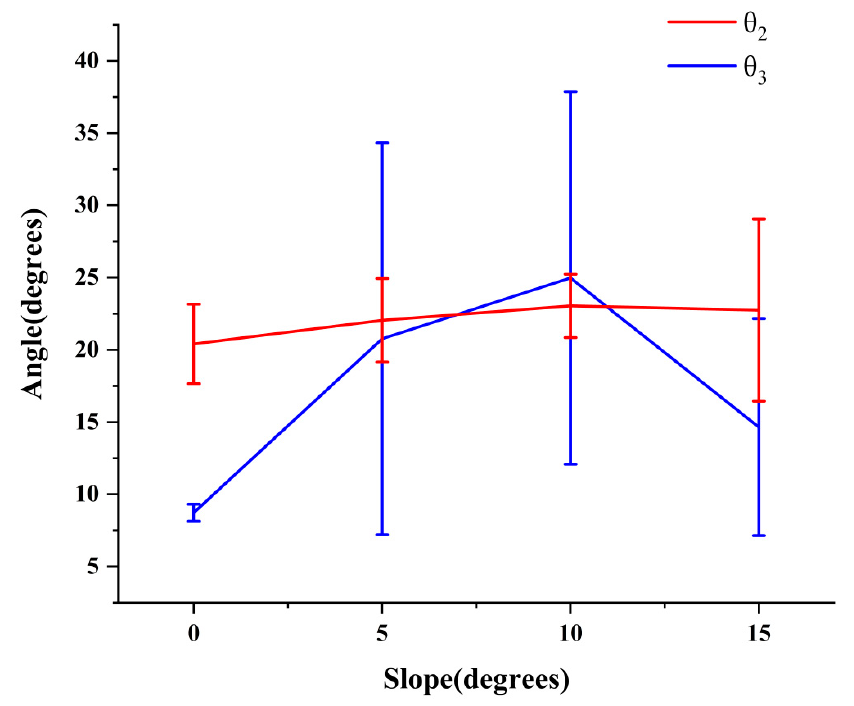
Figure 12. The variation range of θ 2 and θ 3 .